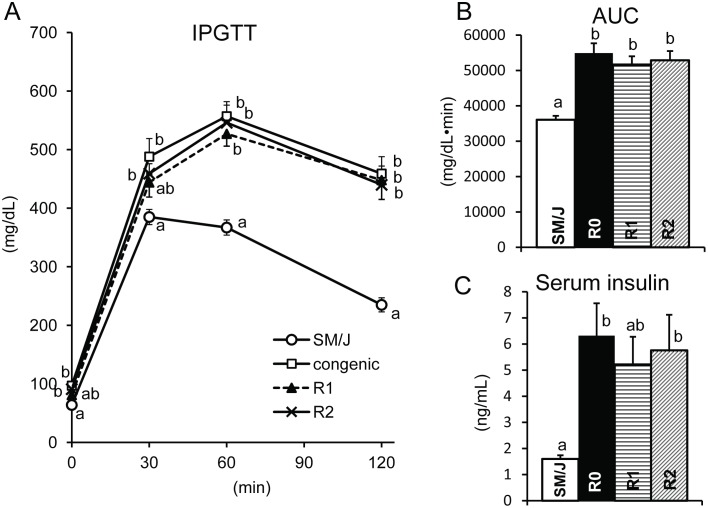
Diabetes-related traits in SM/J, original congenic R0, and congenic (R1, and R2) strains.A. The blood glucose concentrations and B. AUC during the glucose tolerance test, and C. serum insulin concentrations. abc,Means not sharing a common superscript letter were significantly different among SM/J, original congenic (R0), R1, and R2 congenic strains by Tukey-Kramer test.